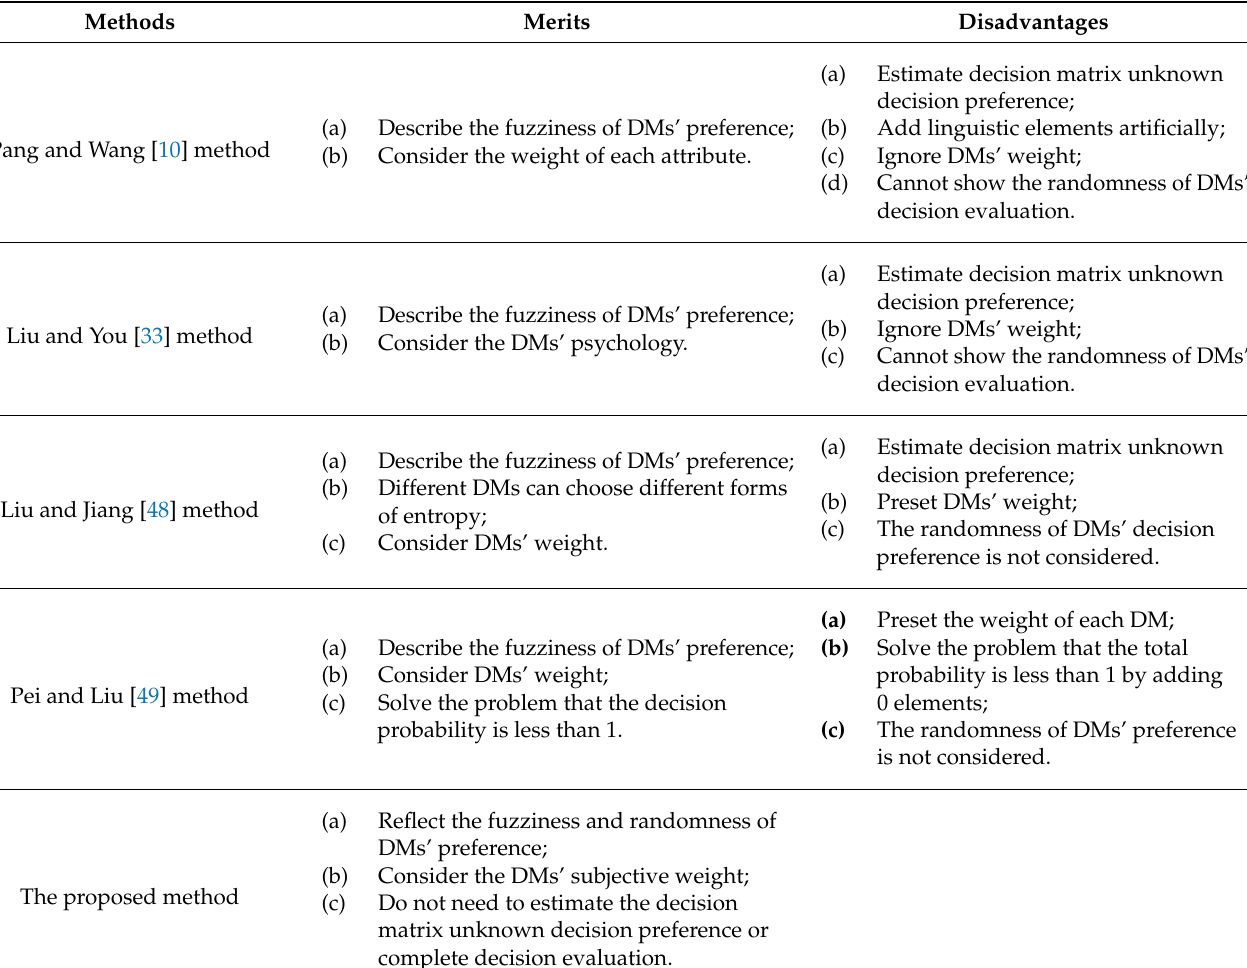
Table 7. Comparison with other